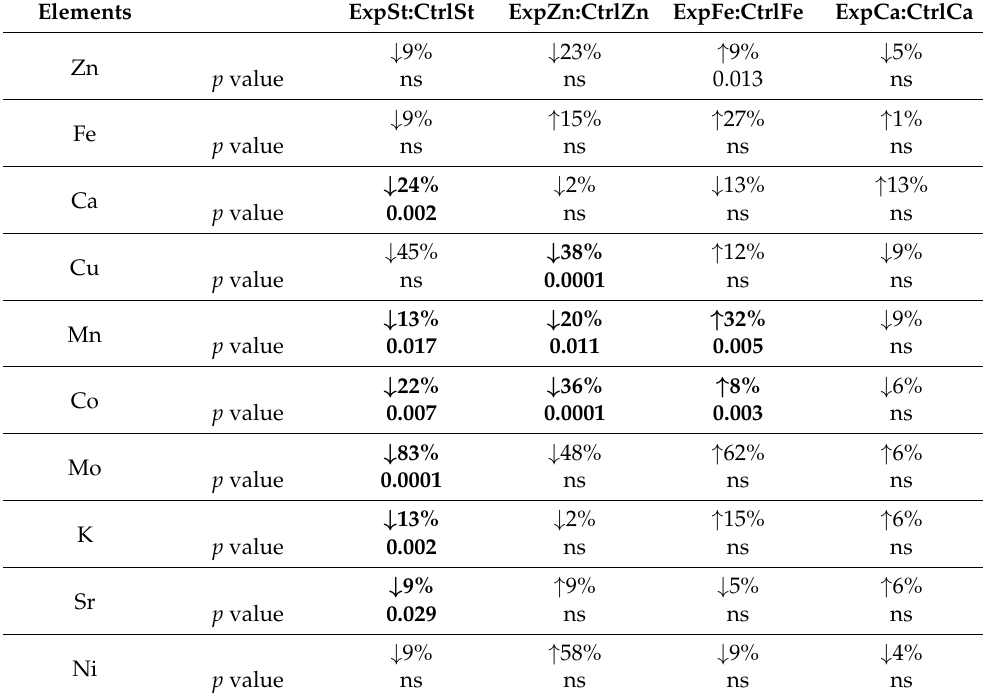
Table 6. Direction and percentage of changes in the elements in the bone of rats with cancer receiving various diets as compared to the control group on the same diet. Statistically significant results are